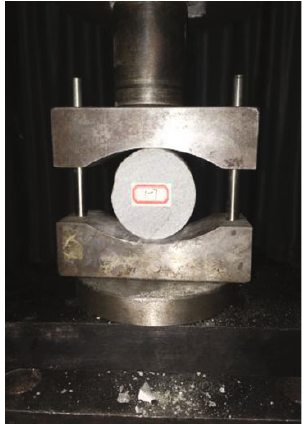
Figure 4: Brazilian splitting test.